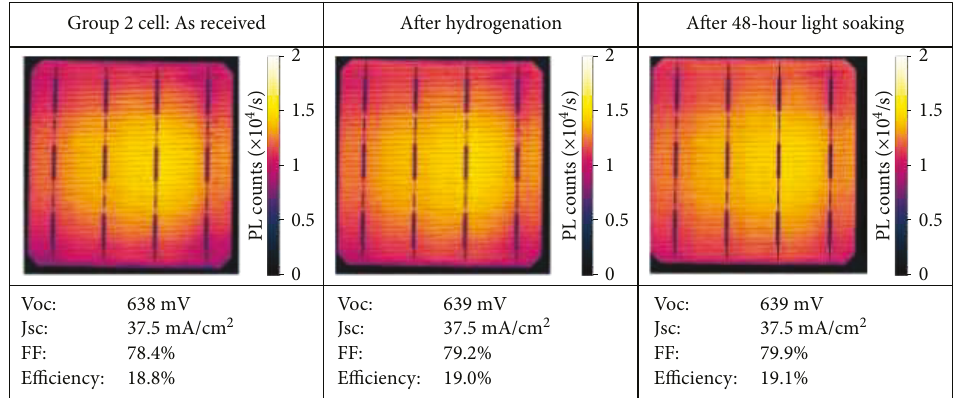
Figure 6: Performance of a group 2 contaminated cell after hydrogenation showing stable lifetimes after light